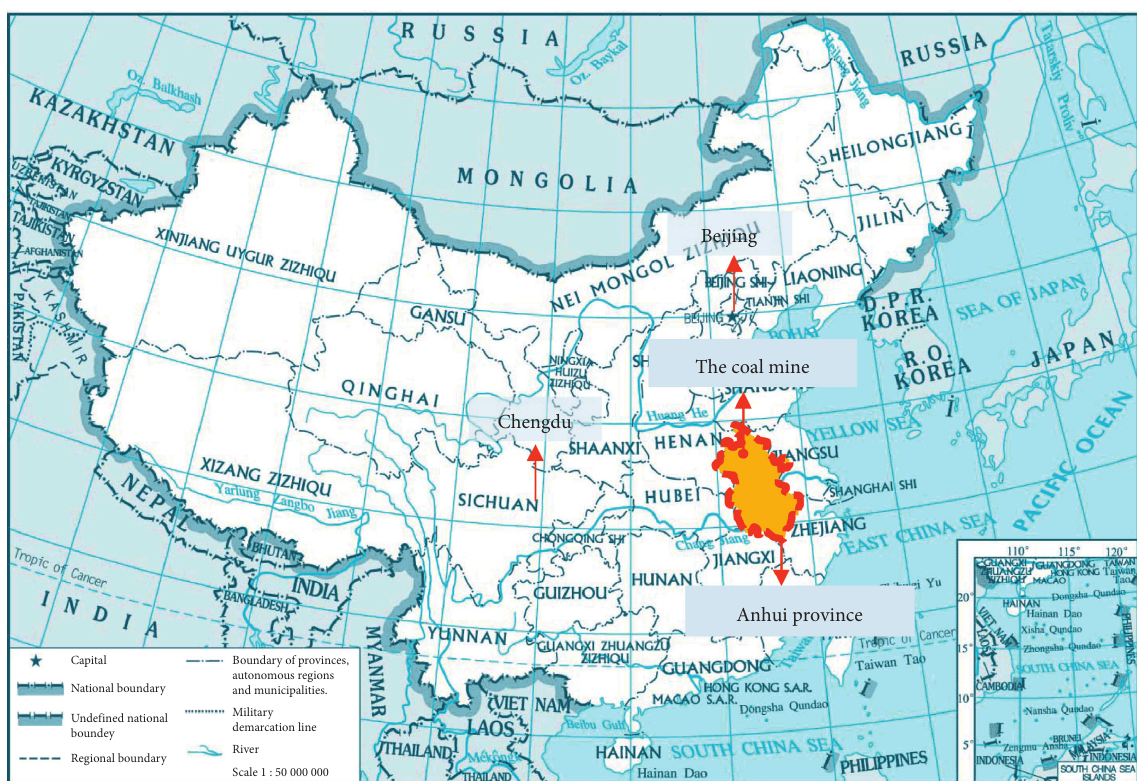
Figure 1: Location of the coal